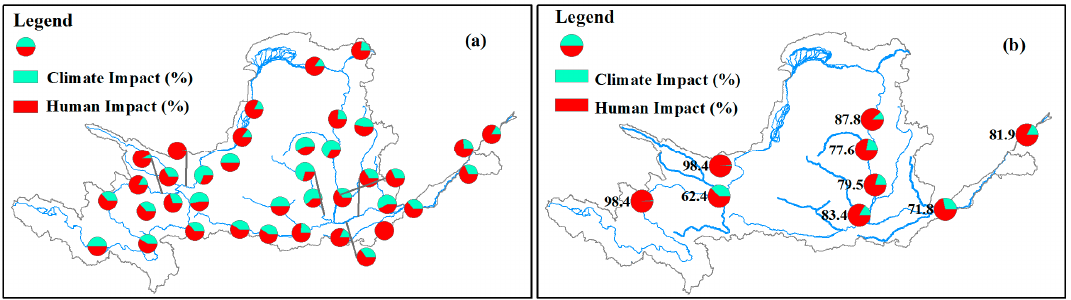
Figure 6. Spatial distributions of the fractional contributions of human activities and climate change to streamflow variations during Period 2 ( a ) and Period 3 ( b ) across the Yellow River basin.